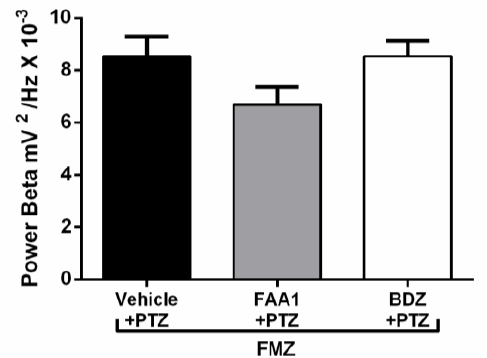
Figure 9. Means of power recordings in beta oscillations of groups treated with Vehicle, BDZ (5 mg/kg) and FAA1 (300 mg/kg) after induction of seizures with PTZ and subsequent administration of Flumazenil (0.1 mg/kg). Results in mV 2 /Hz × 10 −3 and represent mean ± SD ( n = 9), using one-way ANOVA, followed by a post-hoc Tukey test.